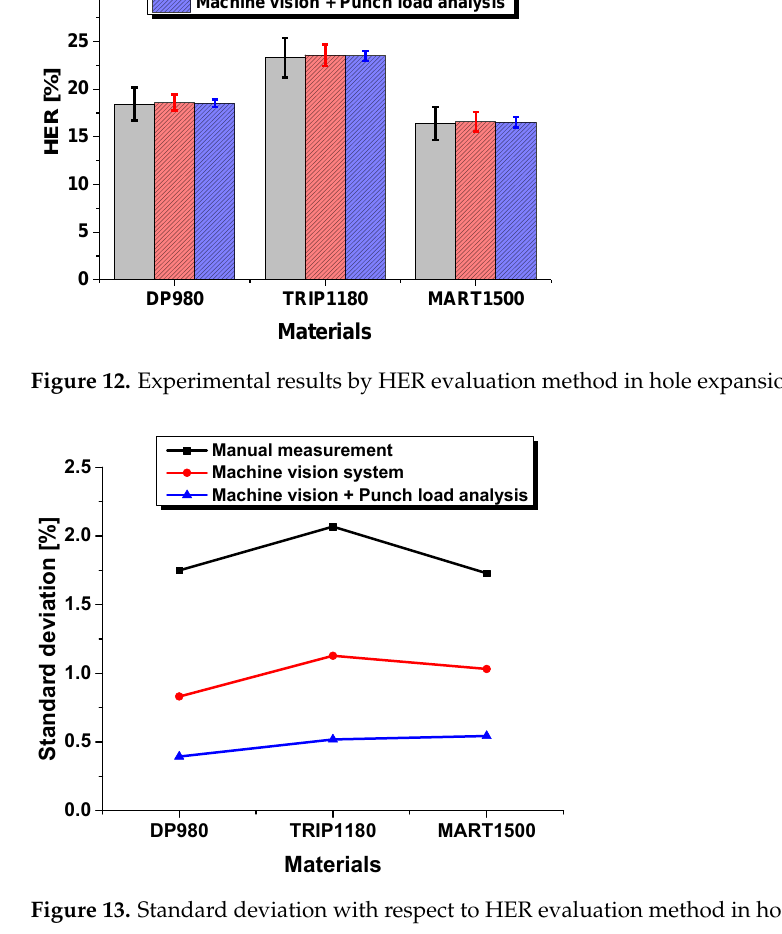
Figure 13. Standard deviation with respect to HER evaluation method in hole expansion test.